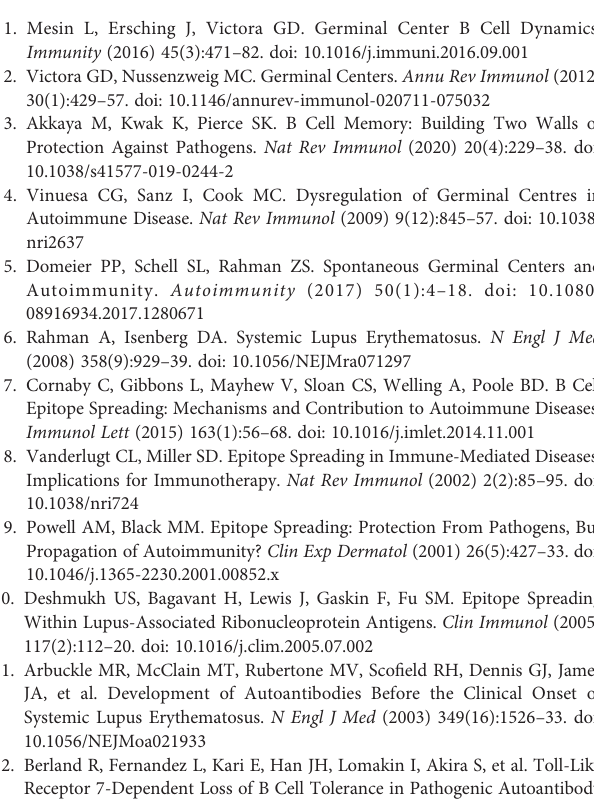
Confocal micrograph of spleen section from a representative TLR7-KO chimera (left) and a WT control (right), stained for CD169 (green) for marginal zone indication and IgD (red) to indicate follicles and GCs (exclusion zones). Supplementary Figure 5 | Assessment of chimerism for the cGAS mixed BM chimeras and controls. (A) B cell frequencies out of live, singlet lymphocytes, in blood of cGAS-KO (blue, n = 7) and WT (red, n = 7) chimeras. Each dot represents an individual mouse and bars indicate mean +/- SD, with statistical signi fi cance given for unpaired t test ( a = 0.05), ns = not signi fi cant, * = p<0.05. (B) As in (A) , but for CD4 + T cell frequencies instead. (C) As in (A) , but for CD8 + T cell frequencies instead. (D) CD45.1 neg fraction of CD4 + T cells from (B) , strati fi ed for PA-GFP status.BlackbarsindicatemeanofCD45.1PA-GFP doublenegativecells,whereas pink bars indicate mean of CD45.1 negative PA-GFP positive cells. Error bars indicate the SD of the mean. Dotted lines illustrate expected frequencies of 33.3% and 66.6% on the y-axis. (E) As in (D) , but for CD8 + T cells from (C) instead. (F) As in (D) and (E) but illustrating CD45.1 positive compartments of the CD4 + and CD8 + T cells, respectively. Dotted line illustrates the expected frequency of 33.3% on the y-axis. (G) as (D) , but for B cells from (A) instead and with dotted line at the expected frequency of 50% on the y-axis. (H) As (A) , but for 564Igi idiotype (9D11 + ) frequencies of B cells. (I) Anti-dsDNA Ab in blood of cGAS-KO (blue, n = 7) and WT (red, n = 7) chimeras. Each dot represents an individual mouse and bars indicate mean +/- SD, with statistical signi fi cance given for unpaired t-test ( a = 0.05), ns = not signi fi cant, ** = p<0.01. Grayed area represents the background level of C57BL6 mice. (J) Relative IFN- b / b -actin mRNA expression in bone marrow- derived cGAS-KO (blue) or WT (red) macrophages, upon mock stimulation or stimulation with dsDNA, as indicated. Each dot represents an experimental replicate, and bars indicate mean +/- SD, with statistical signi fi cance given for two-way ANOVA followed by Sidak ’ s post-test ( a = 0.05), ns = not signi fi cant, **** = p<0.0001. (K) Confocal micrograph of spleen section from a representative cGAS-KO chimera, stained for CD169 (green) for marginal zone indication and IgD (red) to indicate follicles and GCs (exclusion